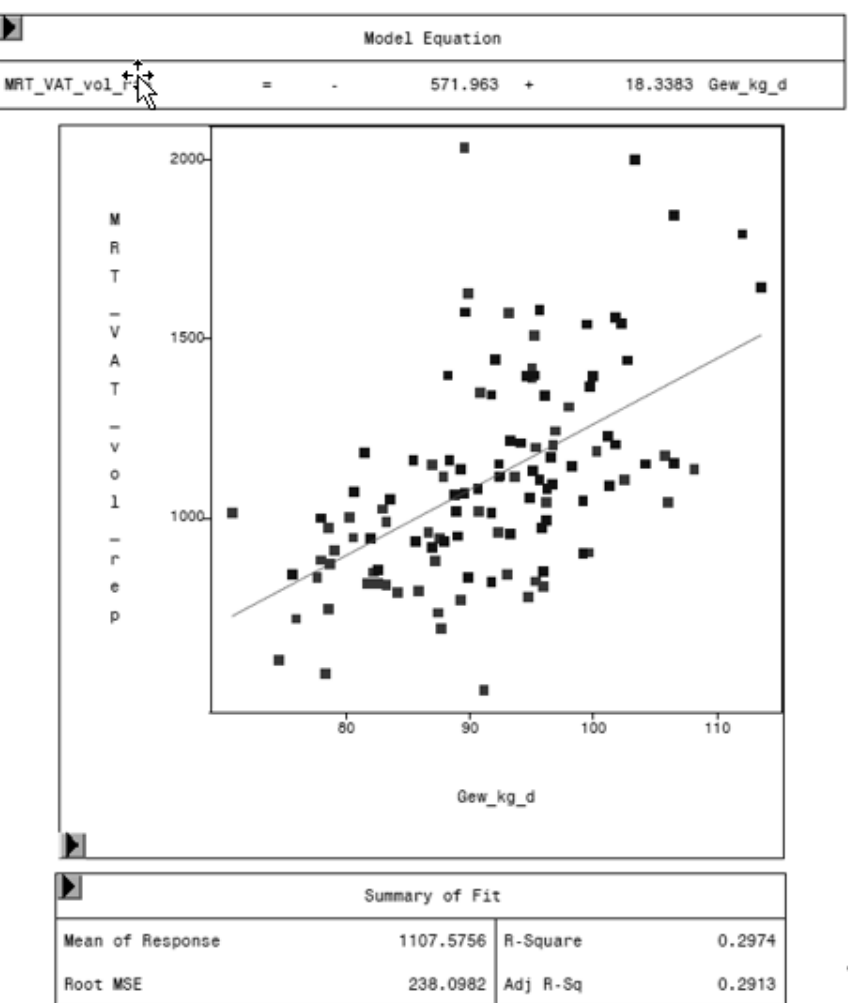
Figure 11. Relationship between VAT volume measured by MRI (MRT_VAT_vol_rep, in cm 3 ) and body weight (Gew_kg_d, in kg) of the animal. Table 5. Relationship between MRI VAT volume and DXA VAT volume in “thick” mode and the age of the pig.